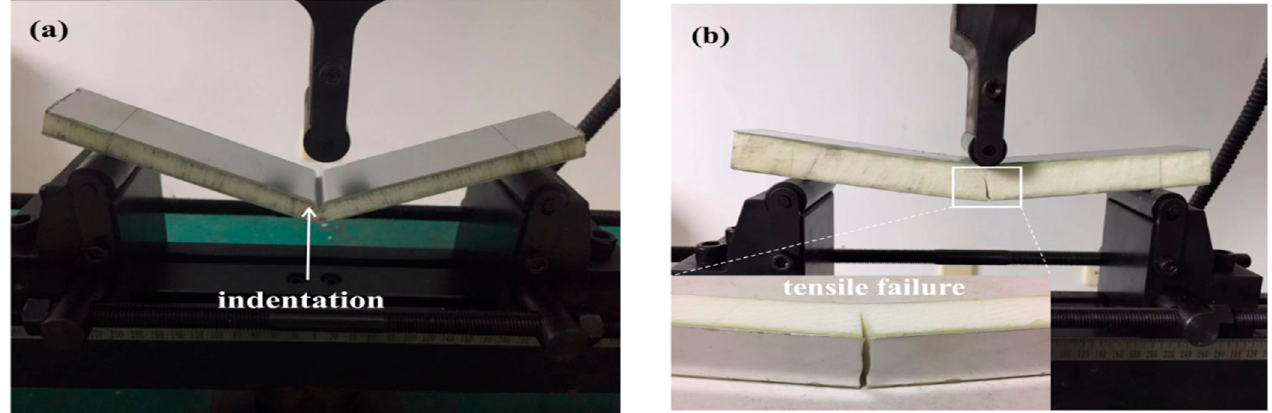
Figure 12. Typical failure modes of the three-point bending tests: ( a ) indentation failure mode of A-0.5/10/0.5; ( b ) typical tensile failure mode of C-0.5/10/0.5.